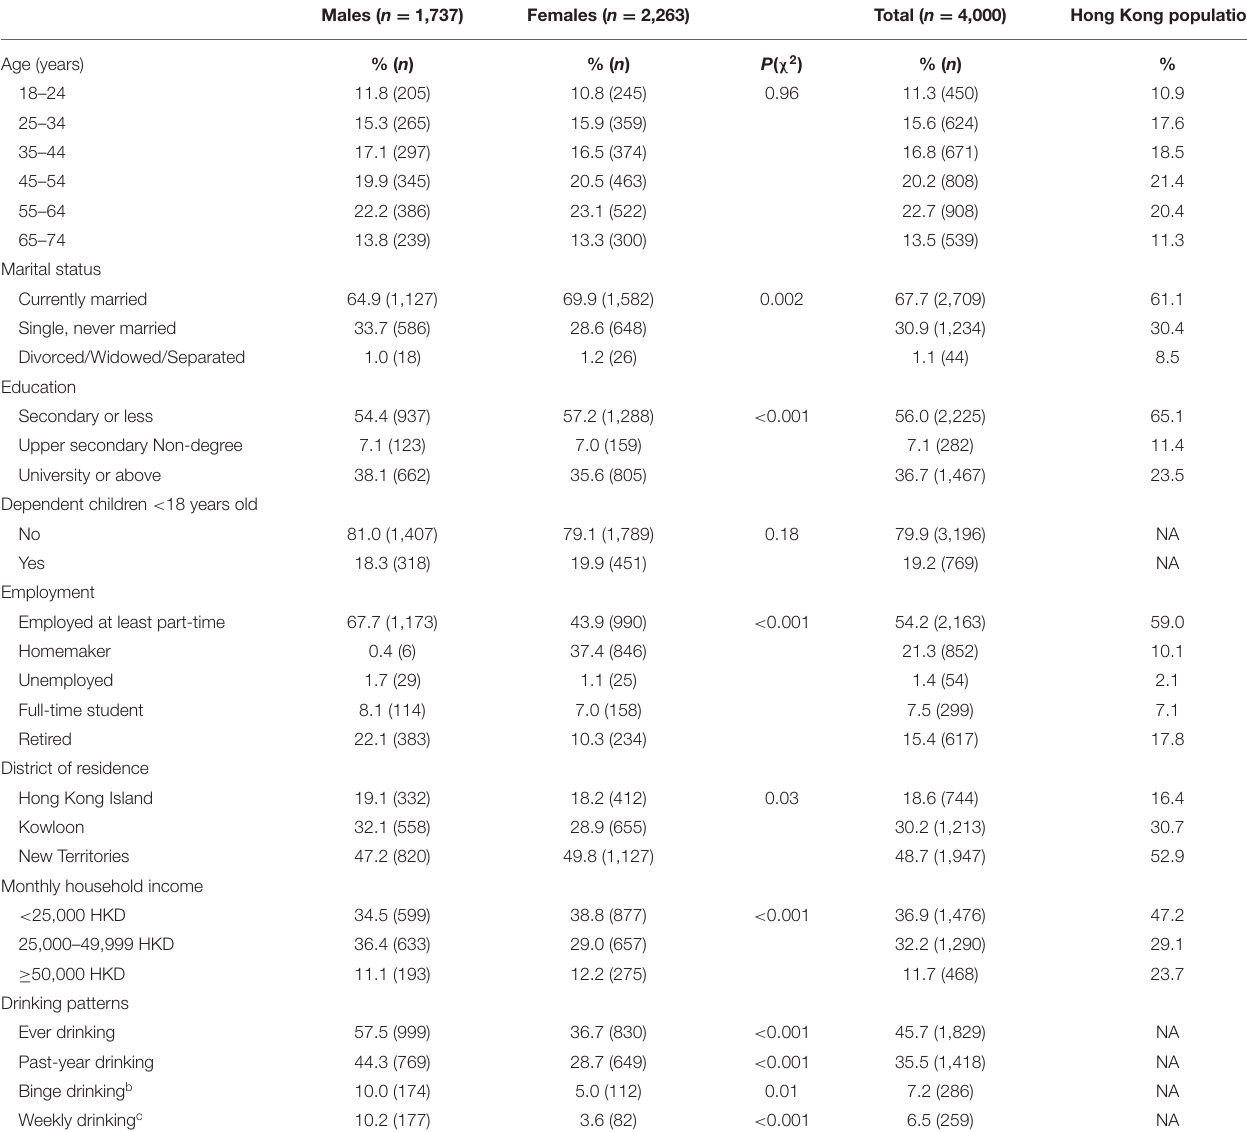
TABLE 1 | Background characteristics of the study sample ( n =